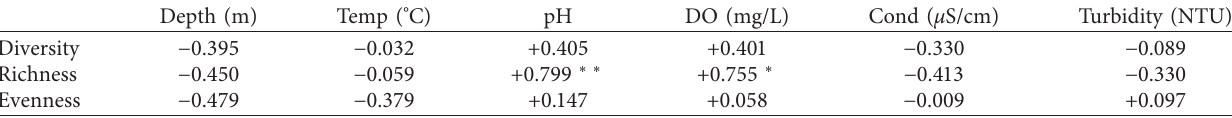
Table 3: Correlation between in situ water quality and fish biological indices at the Murum River.